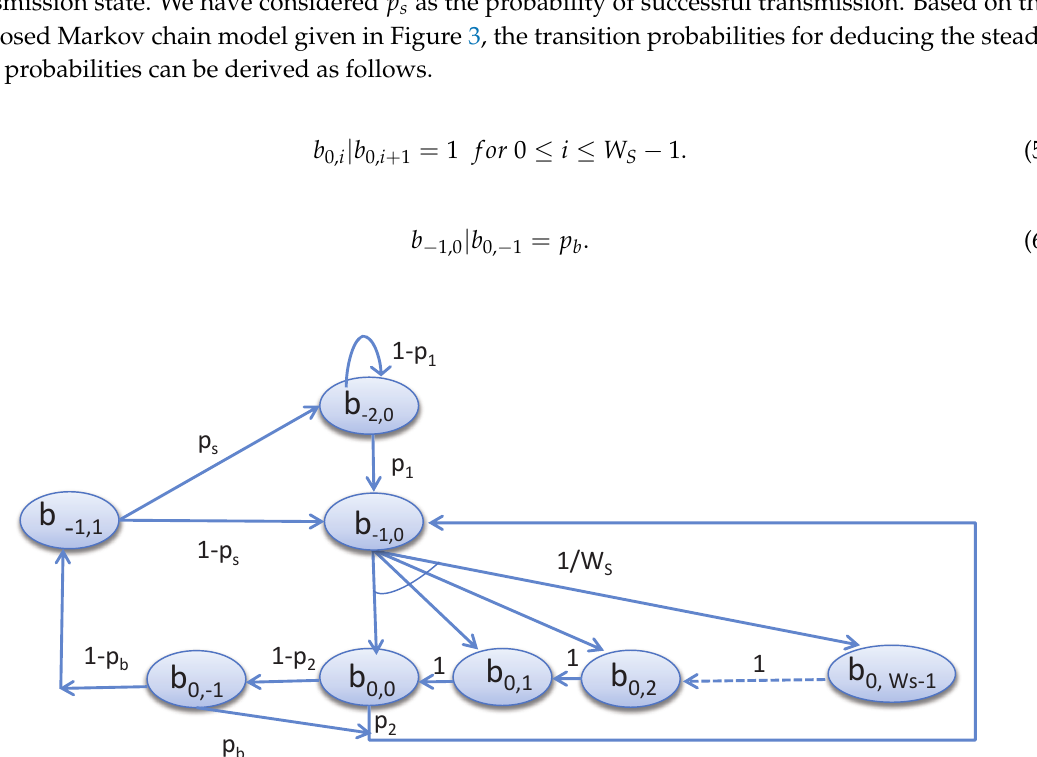
Figure 3. Markov models for the proposed CSMA-CA